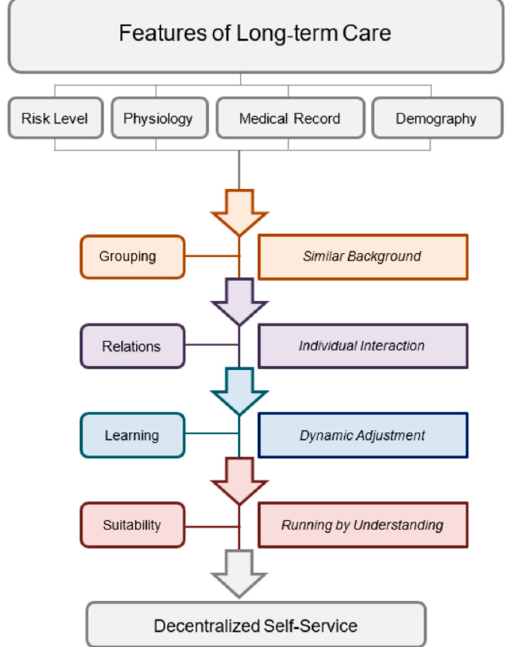
Figure 1. The Decentralized Self-Service Framework. In an existing centralized